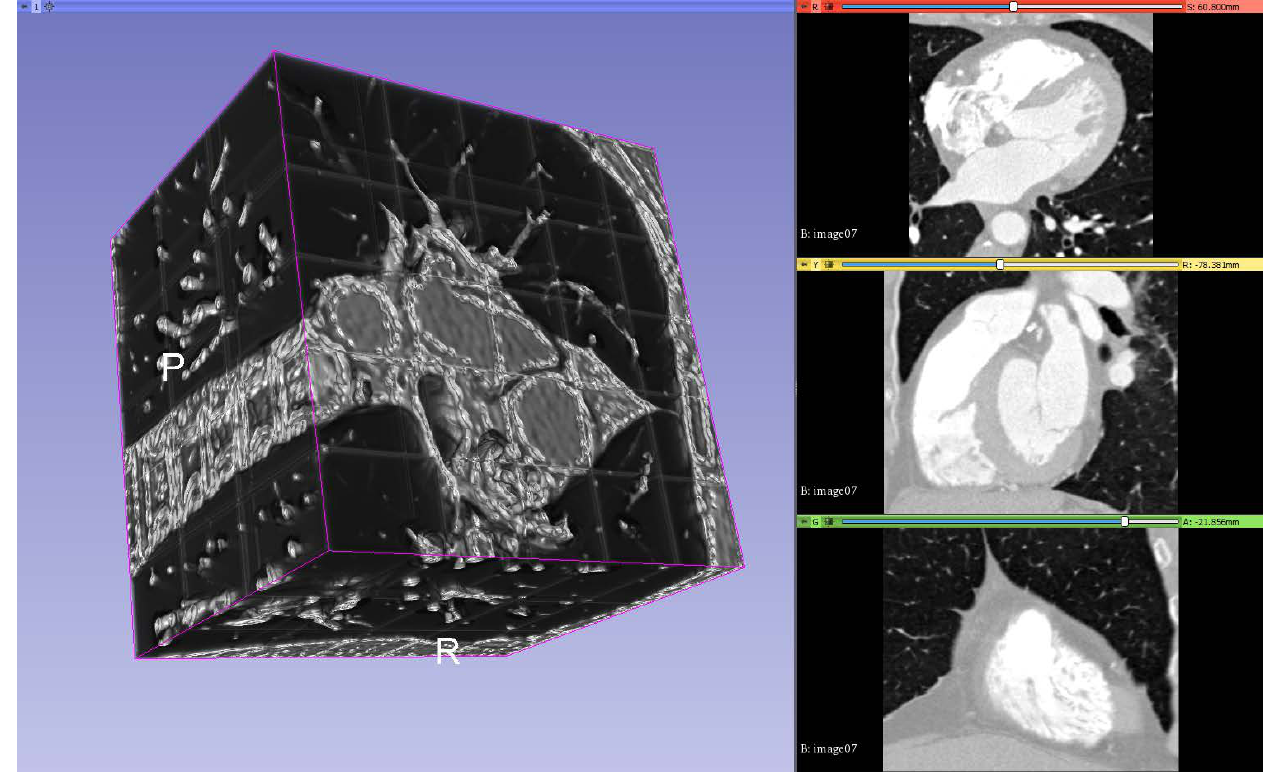
Figure 4. Output volume composed of patches with visible